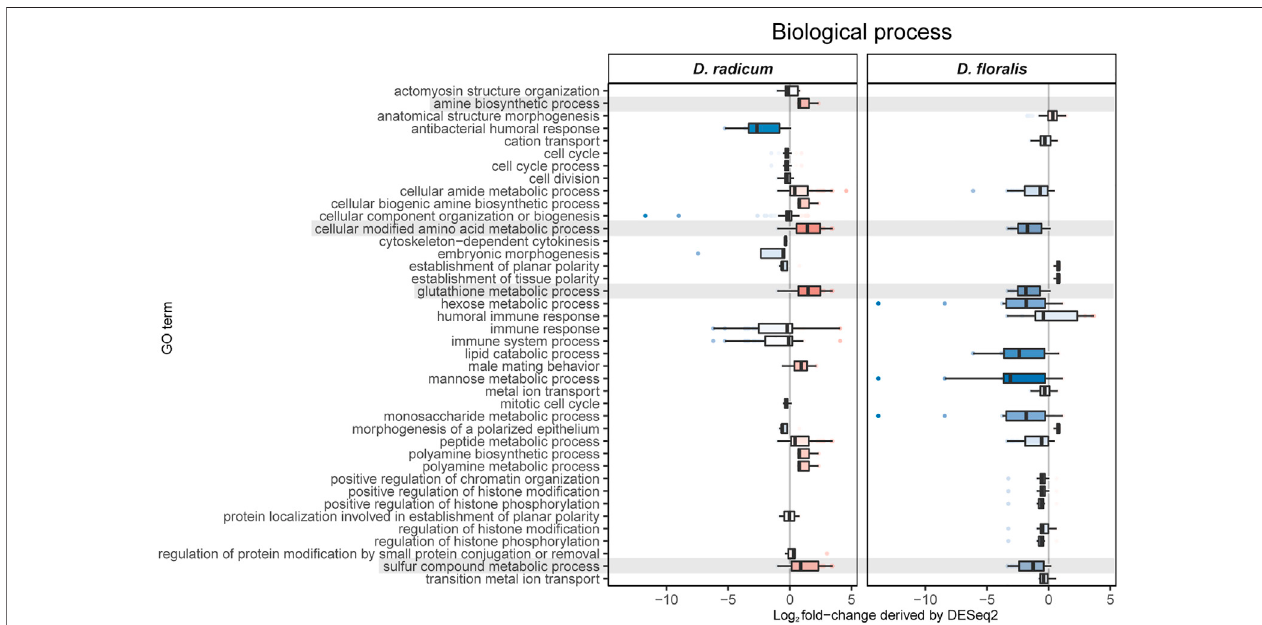
FIGURE 4 | Gene ontology analyses of biological processes based on differently expressed GO terms in Delia radicum and D. fl oralis larvae exposed to 2- phenylethyl isothiocyanate (2PE- ITC) in their diet. Box plots show the distribution of Log 2 fold-changes. Results are presented by medians (horizontal bar), interquartile ranges(IQRs;boxes),anddataranges(whiskers)excludingoutliers(de fi nedas > 1.5xIQR).Rows(boxes)arelabeledbyGOterms.OnlyGOtermsthatweresigni fi cantly differentially observed between control and 2PE-ITC in a GO-enrichment analysis ( p < 0.05) are considered. Red colors: upregulated, blue colors: downregulated, Intensity of color: strength of up- or downregulation, grey color: GO terms of